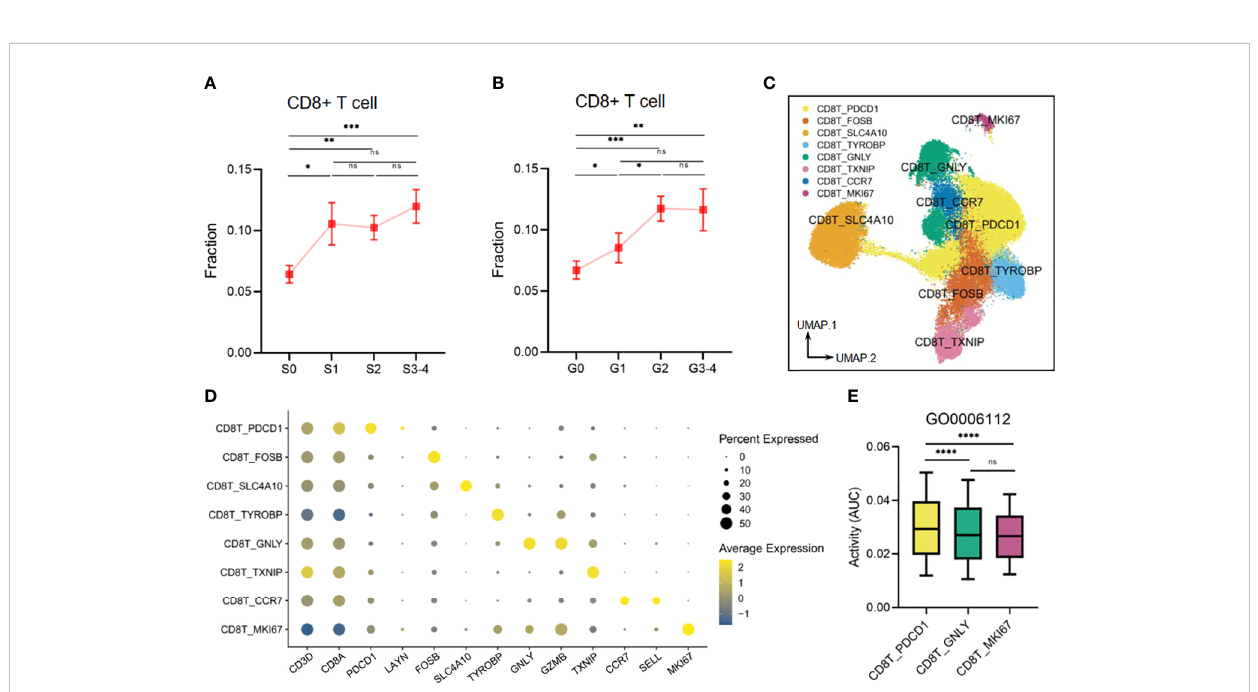
FIGURE 10 The metabolic perturbations of CD8T clusters in hepatitis. (A) The in fi ltration fraction of CD8+ T in groups with different degrees of fi brosis. (B) The in fi ltration fraction of CD8+ T in groups with different degrees of in fl ammation. (C) UMAP visualization of the CD8T clusters. (D) Dot plot showing the expression levels of given genes in each cluster. (E) The activities of the metabolic pathway in several CD8T clusters. Data in panels A and B are mean ± SEM. UMAP, Uniform Manifold Approximation and Projection. ****means p < 0.0001,*** means p < 0.001, ** means p < 0.01, and * means p < 0.05.